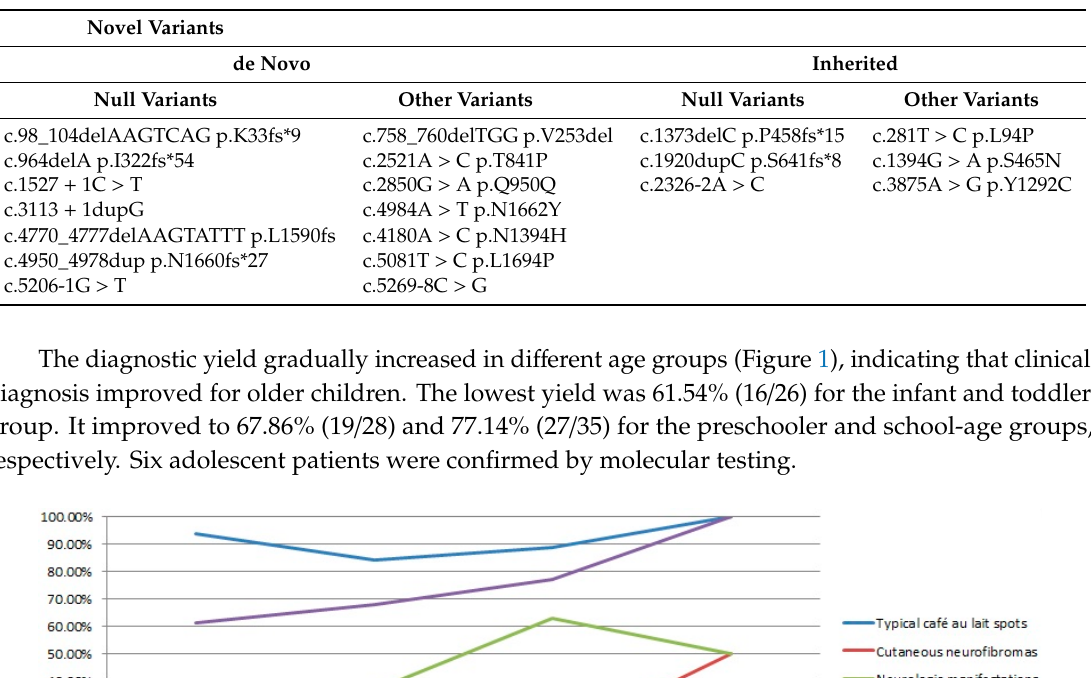
Table 1. Novel variants detected in Chinese neurofibromatosis 1 (NF1) patients.